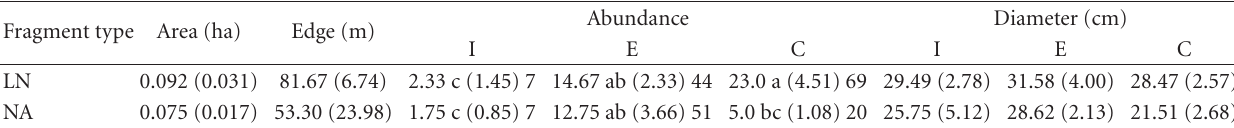
Table 1: Mean (SE) of forest fragment size, tree abundance and tree diameters at fragments occupied by the invasive ant Lasius neglectus (LN) or native ants (NA). Trees were categorized as: isolated trees (I), edge trees (E), or core trees (C). Total abundance of each category is after (SE). Di ff erent letters showed significant di ff erences of post hoc comparisons of the interaction between tree category x fragment type (Tukey, P < 0 .